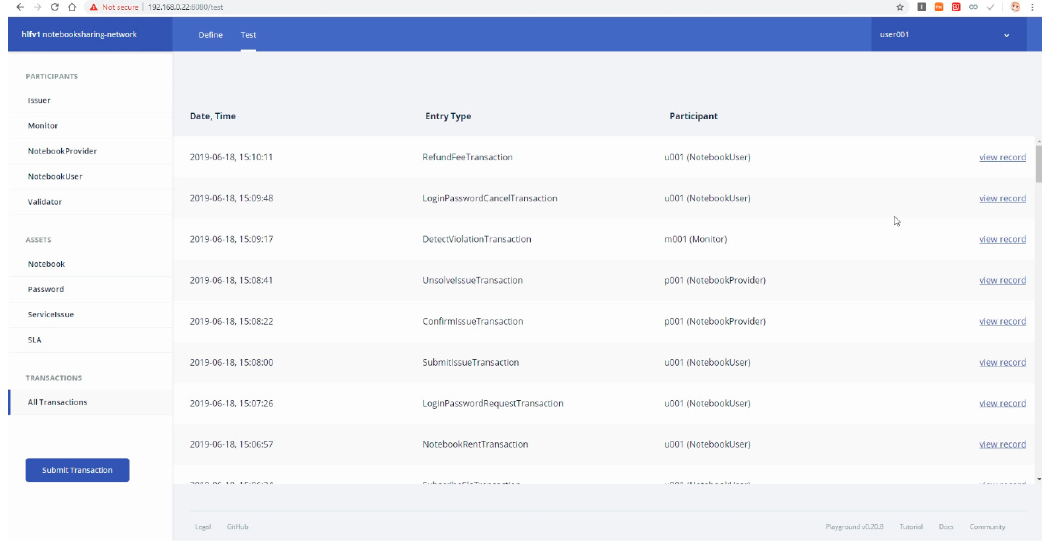
Figure 19. Transaction history in the Composer web playground.